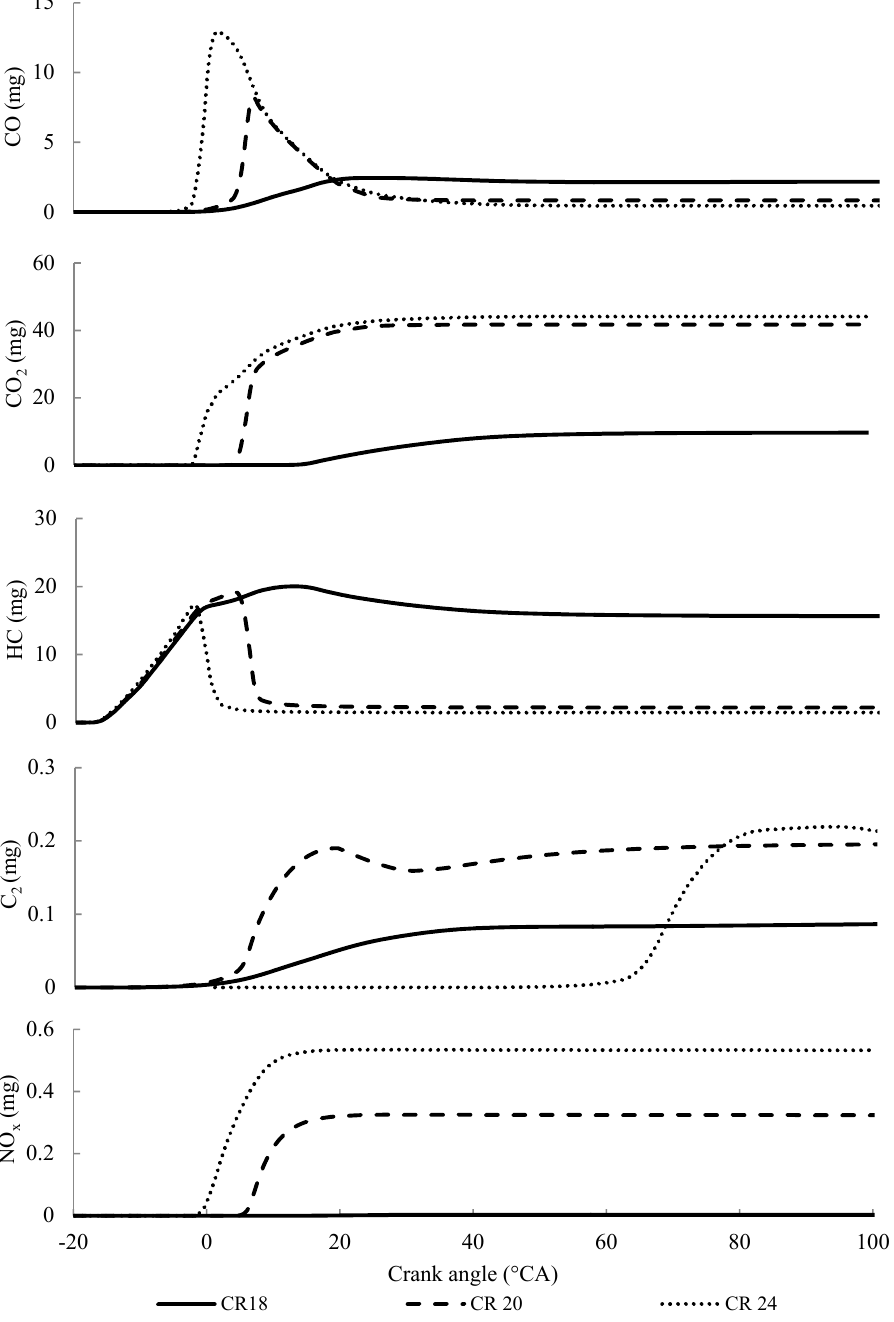
Figure 14. Emission graphs of the D50E40B10 blend at di ff erent compression ratios running at 1600